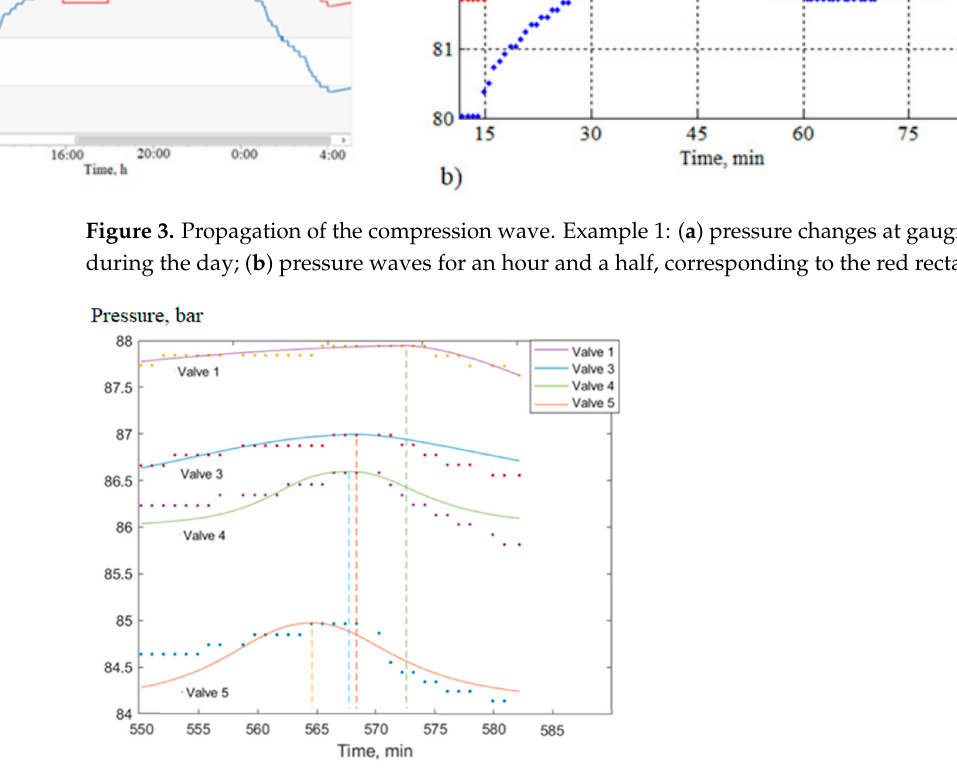
Fluids 2023 , 8 , 45 10 of 24